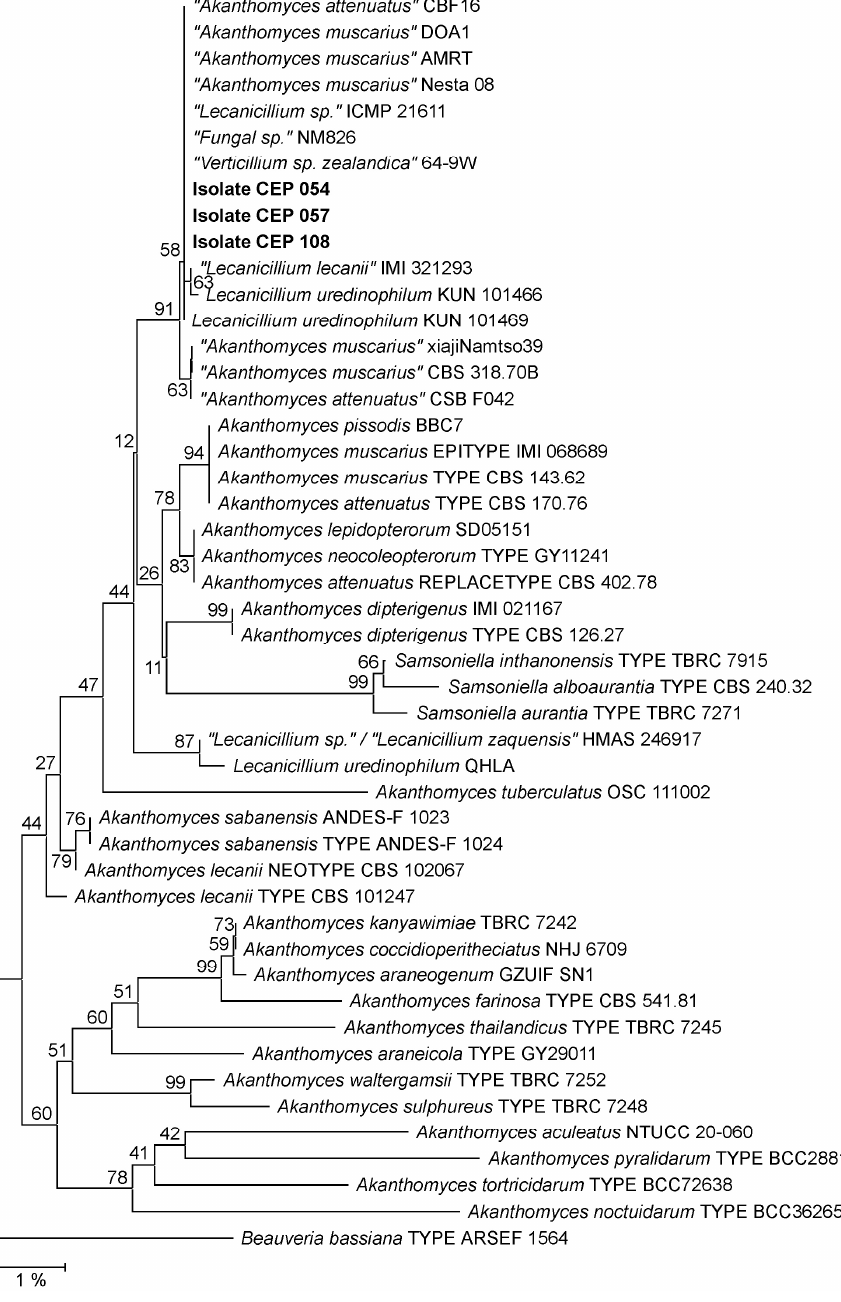
Figure 2. Neighbor joining (NJ) phylogeny of Akanthomyces fungi as reconstructed from ribosomal RNA operon internal transcribed spacer (ITS) sequences. Terminal branches are labeled by genus, species and strain designations; “TYPE” indicates specific type strains. Designations of fungal iso- lates from Argentina are shown in bold face; designations in quotation marks indicate non-reference sequences identified by data mining. Numbers on internal branches indicate bootstrap support per- centages. The size bar corresponds to 1% sequence divergence with respect to phylogram branch lengths. The ITS sequence from the fungal entomopathogen Beauveria bassiana (Hypocreales; Cordycipitaceae) has been used as the outgroup.